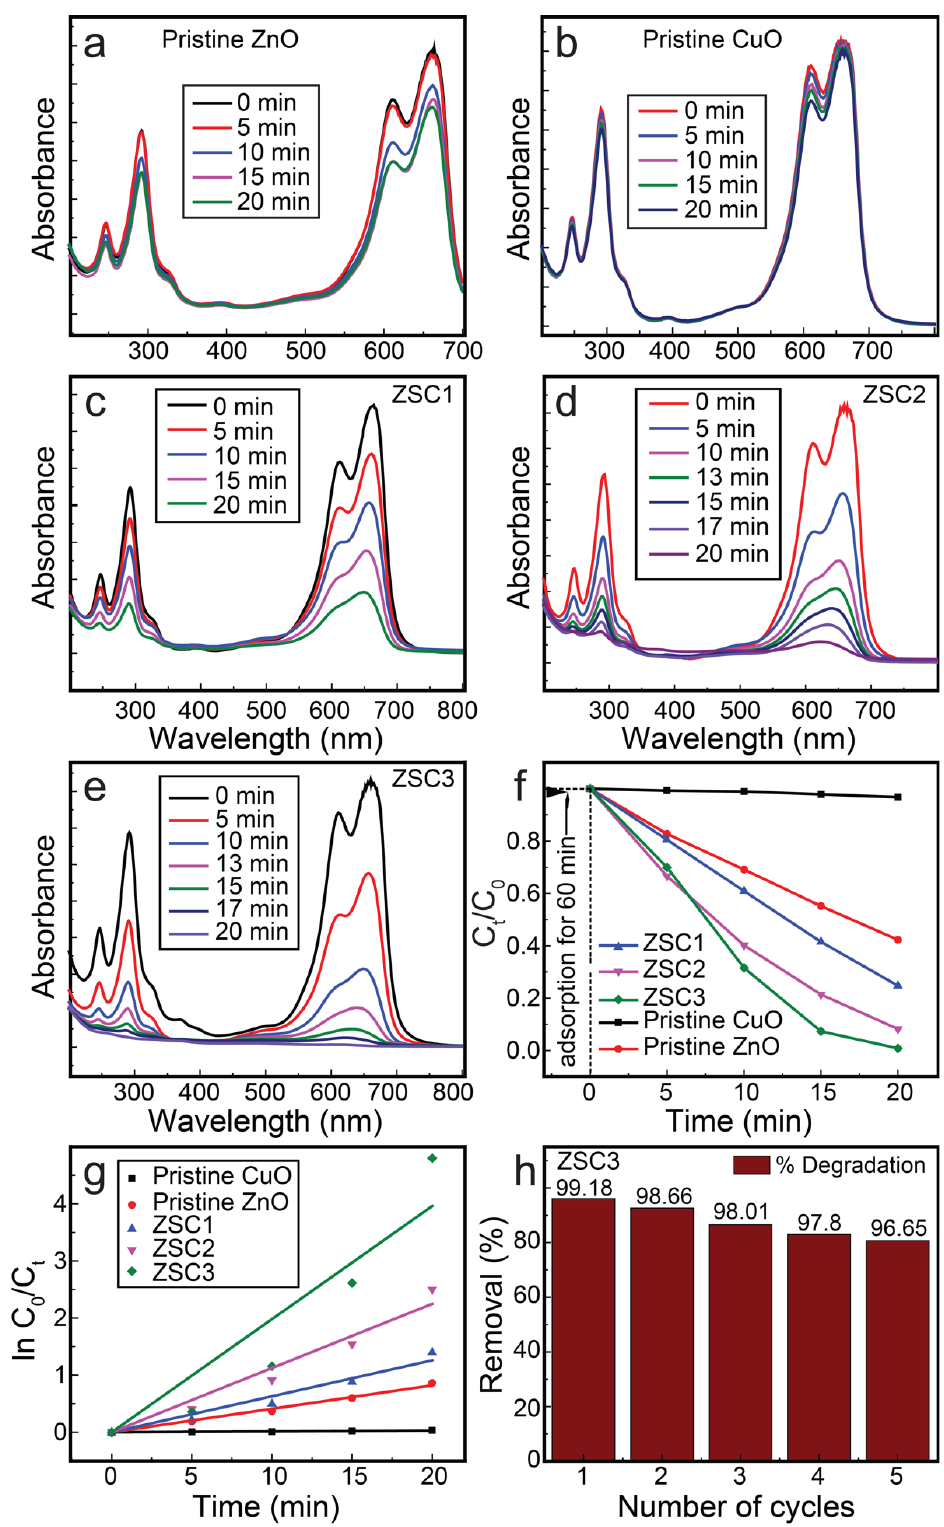
Figure 9. The spectrometric scans for the photocatalytic decomposition of MB in the presence of ( a ) pristine wurtzite ZnO, ( b ) pristine monoclinic CuO, ( c ) ZSC1, ( d ) ZSC2, and ( e ) ZSC3. ( f ) Concentration degradation plot as a function of time. ( g ) Kinetic plot for all the samples. ( h ) The stability results for ZSC3 heteronanocomposite.